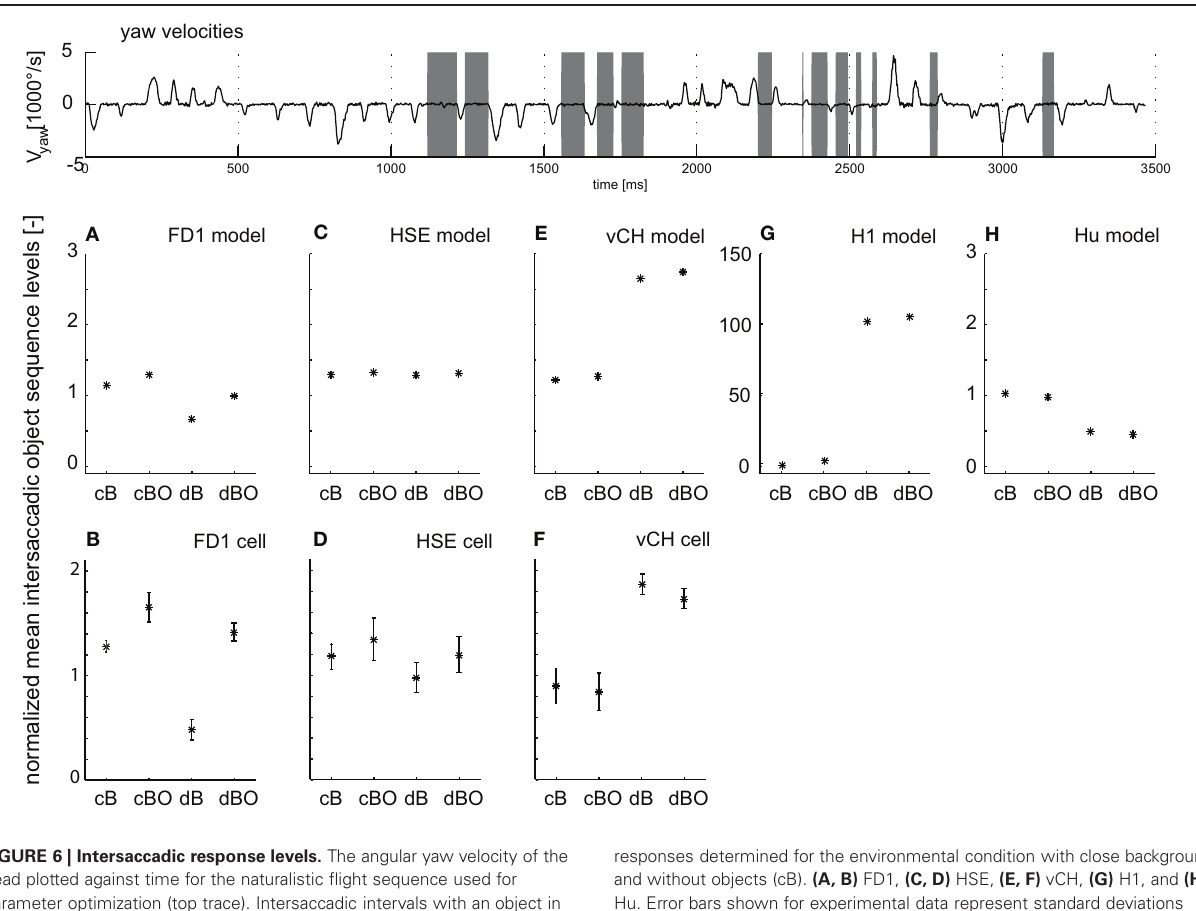
FIGURE 6 | Intersaccadic response levels. The angular yaw velocity of the head plotted against time for the naturalistic flight sequence used for parameter optimization (top trace). Intersaccadic intervals with an object in the receptive field of the FD1 cell are marked by gray bars. Intersaccadic responses of model cells (middle diagrams) and biological cells (bottom diagrams) averaged over these intersaccadic intervals for all environmental conditions. The responses are normalized to the mean intersaccadic